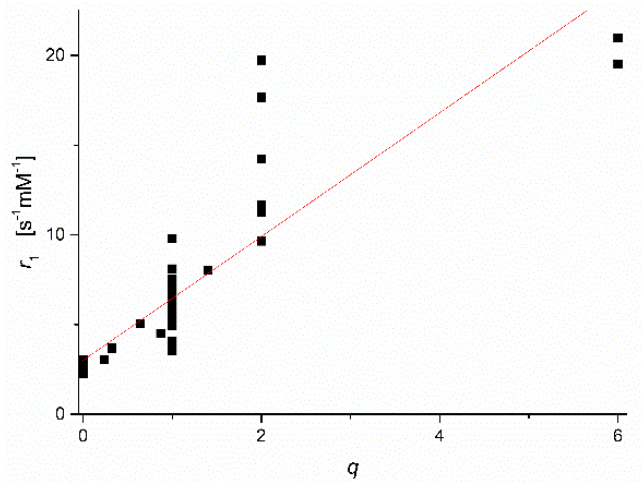
Figure 2. Plot of low field r 1 versus q -values collected from previously reported publications on Mn 2+ -complexes.